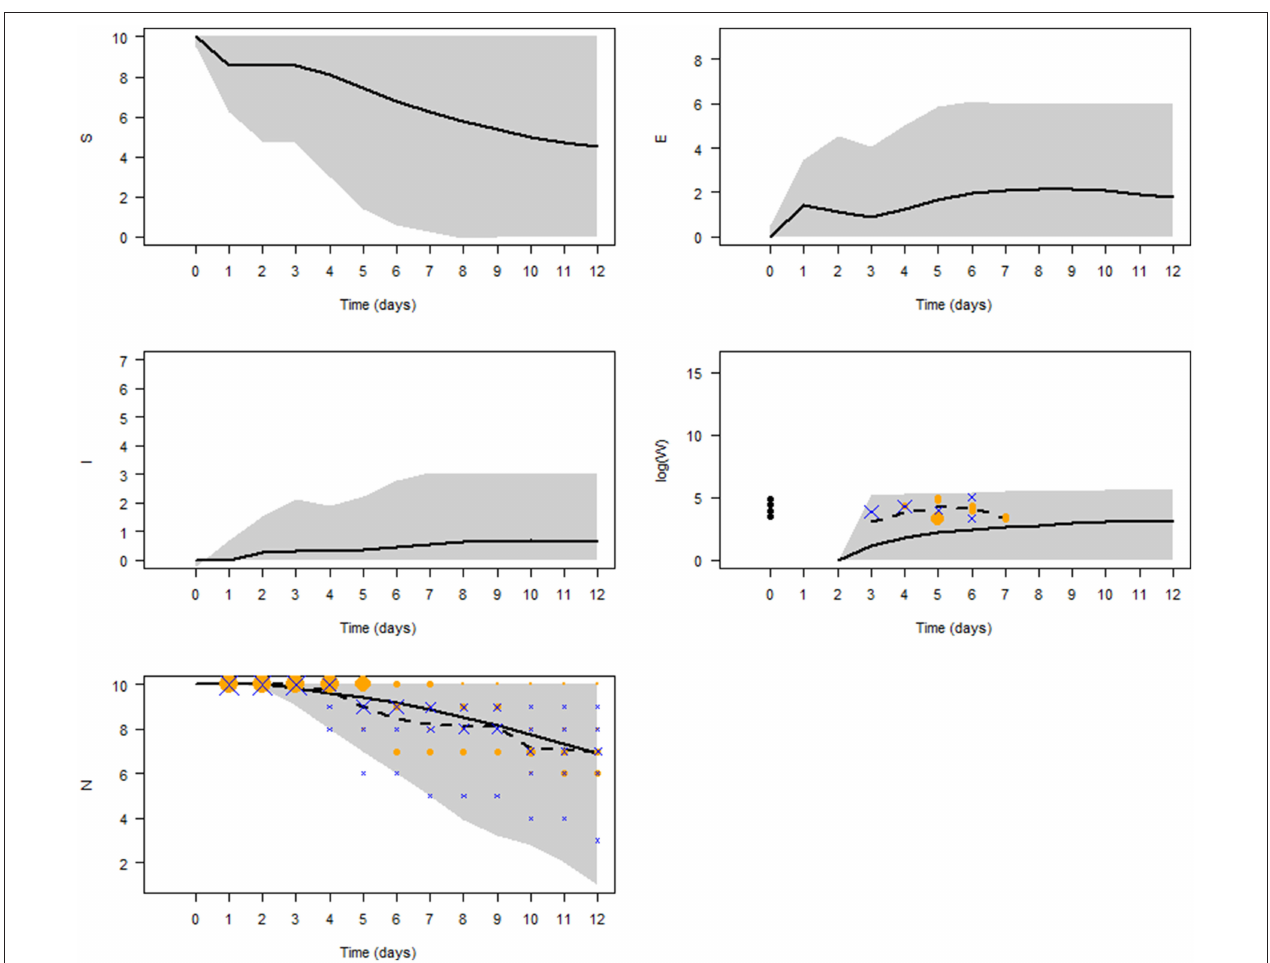
FIGURE 6 | Model predictions. The five panels show the temporal dynamics of susceptible (S), exposed (E), infected (I) oysters, seawater bacterial concentration (W) in log scale, and total population size (N), using the epidemiological parameter values estimated by ABC. The black solid curves show mean values of 10,000 simulations. Gray shading represents the 95% credibility interval. Symbols denote the observed data in 3L tanks during the laboratory experiments (orange dots: low doses; blue crosses: high doses), their size being proportional to the number of observations. The black dashed curve shows mean observed values in the